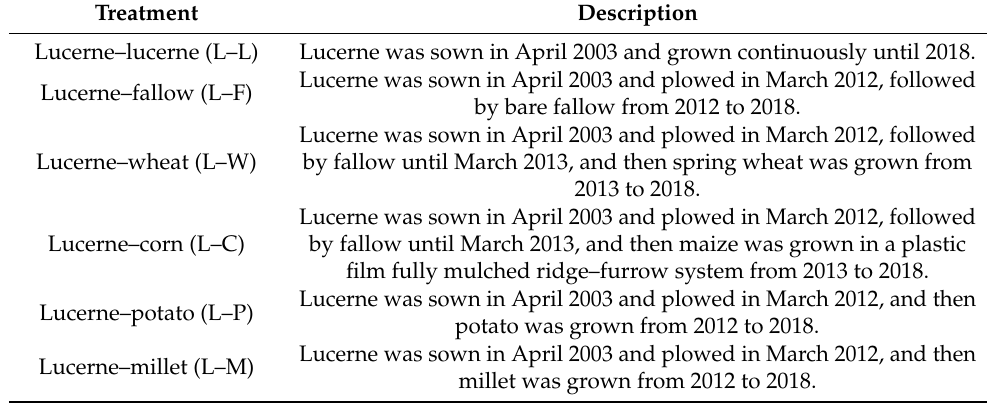
Table 1. Details of experimental